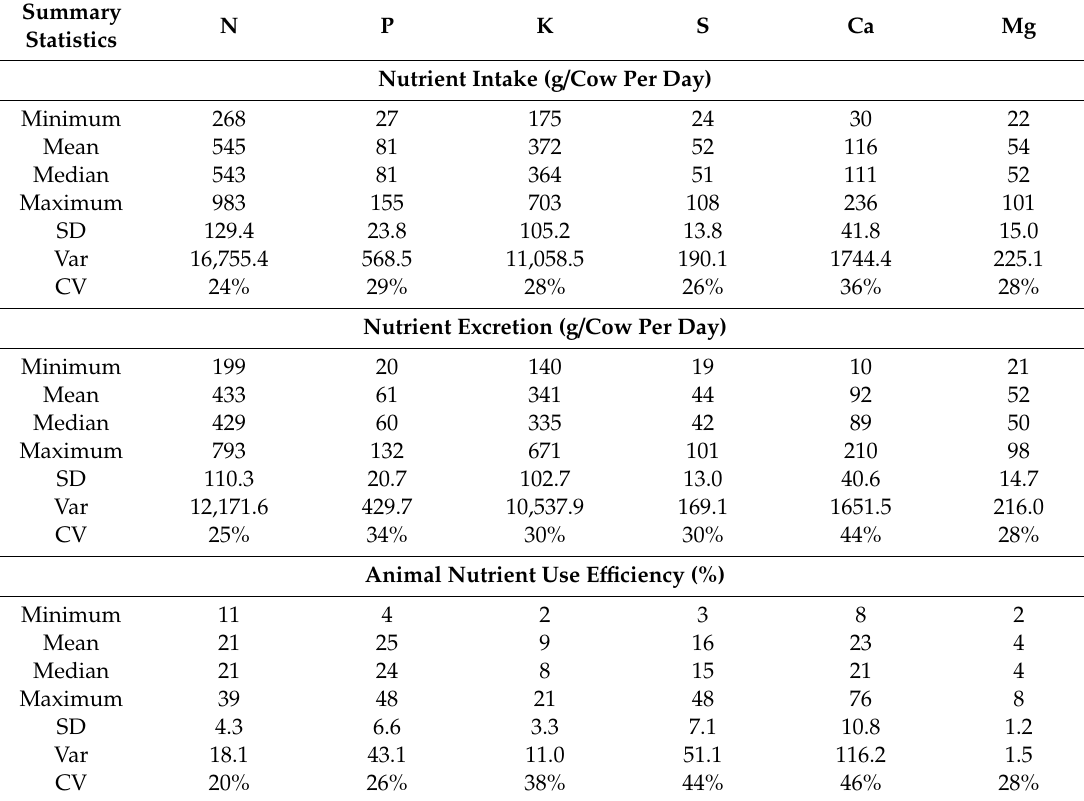
Table 7. Summary statistics for calculated nutrient intake (g / cow per day), excretion (g / cow per day) and animal nutrient use e ffi ciencies (%) across 43 grazing system dairy farms for five